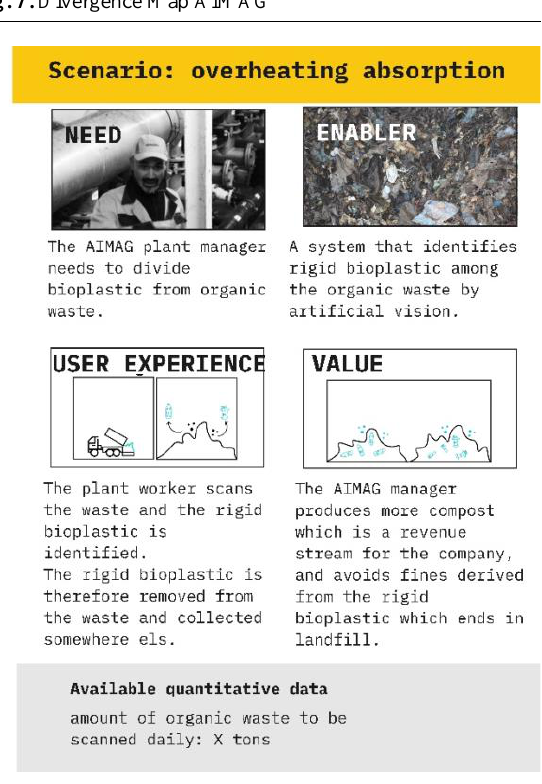
Fig. 8. Tech functional Scenario 3 - AIMAG